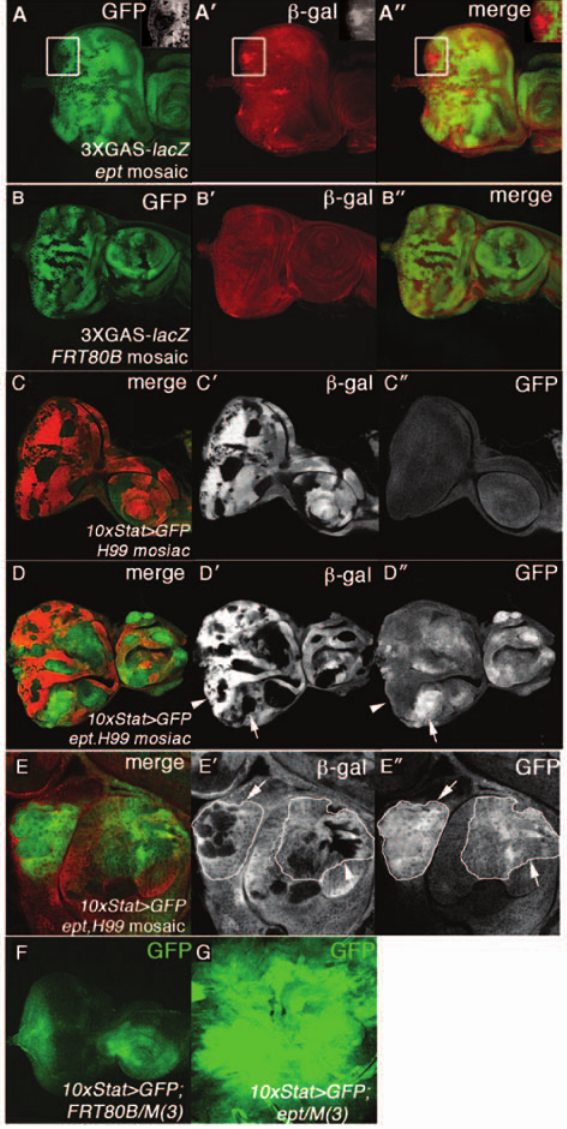
Figure 5. Stat92E sensor activity in ept mutant eye-antennal cells. Eye discs carrying clones of ept 2 mutant cells (A-A 0 ) or FRT80B control cells (B-B 0 ) marked by the absence of GFP (green) and stained for expression of b -galactosidase ( b -gal; red in A 9 and B 9 ) to detect expression of the 3xGAS-lacZ Stat-reporter. Inset in (A-A 0 ) shows an ept 2 mutant clone that shows cell autonomous activation of 3xGAS-lacZ . Because the 3xGAS-lacZ transgene and the ept gene are both located on chromosome arm 3L, the reporter is present in two copies in both FRT80B and ept mutant clones; images in A 9 and B 9 were captured using exactly the same optical settings. (C–E) Expression of the 10xStat . GFP transgene (green) in ept X1 ,H99 mosaic discs in which mutant cells are marked by the absence of b -gal (red). Arrowhead marks clone of ept X1 ,H99 mutant cells in the eye disc that do not activate 10xStat . GFP ; arrow marks an example of an antennal clone that activates 10xStat . GFP within the clone and in surrounding wild type cells. Images in (E-E 0 ) are of the antennal region of an ept X1 ,H99 mosaic disc. White outlines in panel (E 0 ) denotes boundaries of GFP-expressing cells. Expression of the Stat reporter 10xStat . GFP (green) in a control FRT80B/M(3) eye disc (F) and an ept 2 eye-antennal tumor (G). The disc in (F) was imaged at half the fluorescence intensity relative to the control disc in (G).